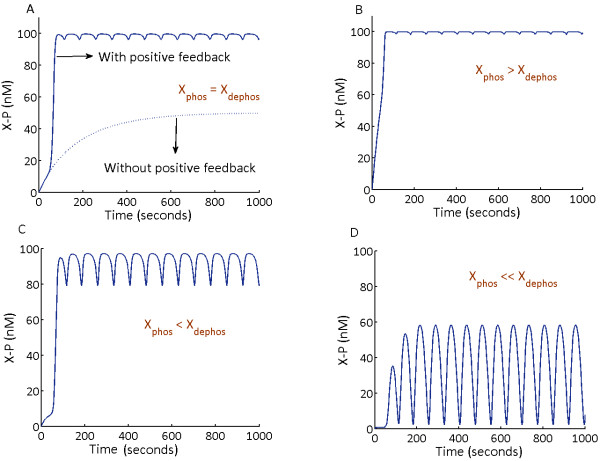
Oscillations in an external signaling module of kinase X by the positive feedback of the MAPK cascade S2. (A) Dynamics of X-P with and without the positive feedback loop when rate of phosphorylation of X (Xphos ) = rate of dephopshorylation of X (Xdephos ). Here Xphos = Xdephhos = 0.1. (B) Dynamics of phosphorylated X (X-P) when Xphos > Xdephos. The Xphos = 0.5 and X dephos = 0.1. (C) Dynamics of X-P when Xdephos.> Xphos. The Xphos = 0.1 and X dephos = 0.5. (D) Dynamics of X-P when Xdephos.> > Xphos. The Xphos = 0.1 and X dephos = 5. In the simulations, total concentration of X was 100 nM (arbitrary). The units of Xphos and Xdephhos is nM.sec-1.